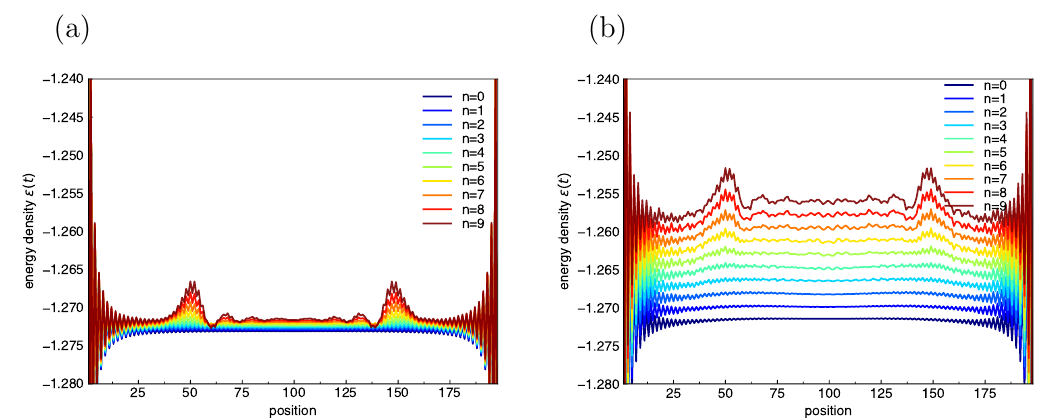
Figure 10: Time evolved energy density E ( x , t ) in the heating phase with driving / L = 0.95, T / L = 0.05 for the dephasing protocol on the boundaries, parameters T 0 1 with dephasing strengths (a) γ = 0.0001 and (b) γ = 0.001. The horizon structure of the heating phase persists in presence of